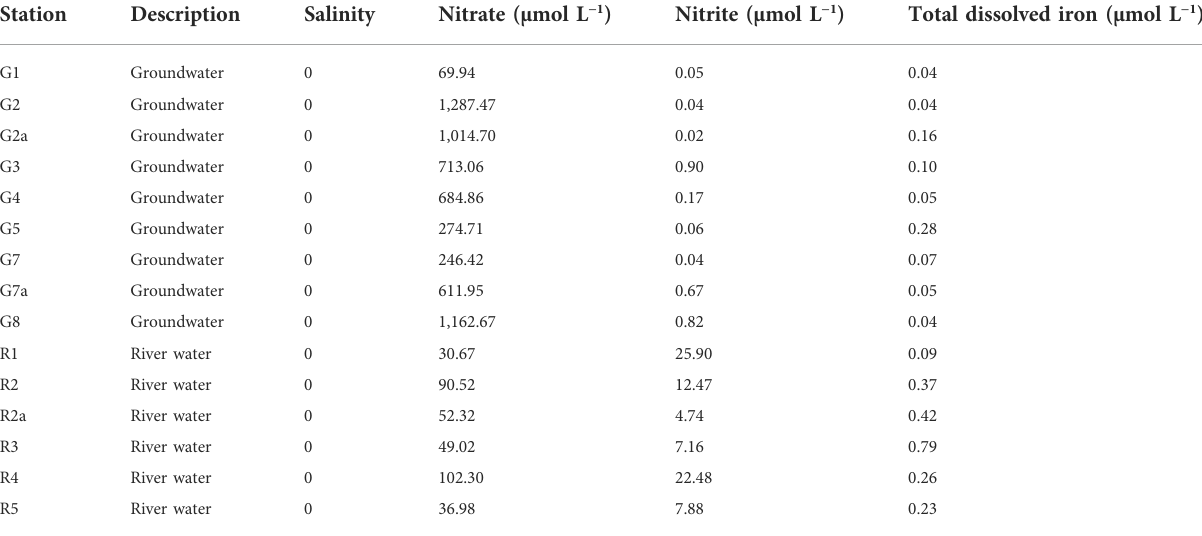
TABLE 1 Salinity, nitrate, nitrite, and total dissolved iron in nine groundwater and six river water samples.